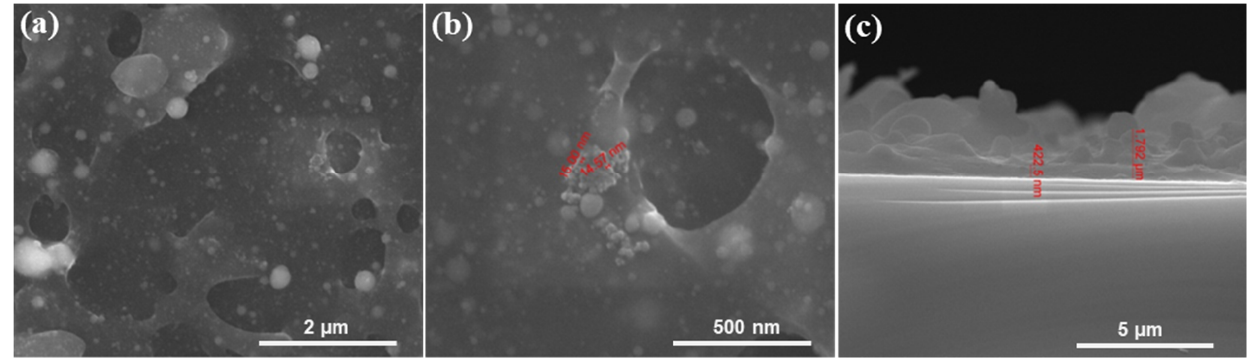
Figure 9. Plain view ( a , b ) and cross-section ( c ) scanning electron microscopy (SEM) micrographs of PLA/Fe 3 O 4 @EG coat- ings.